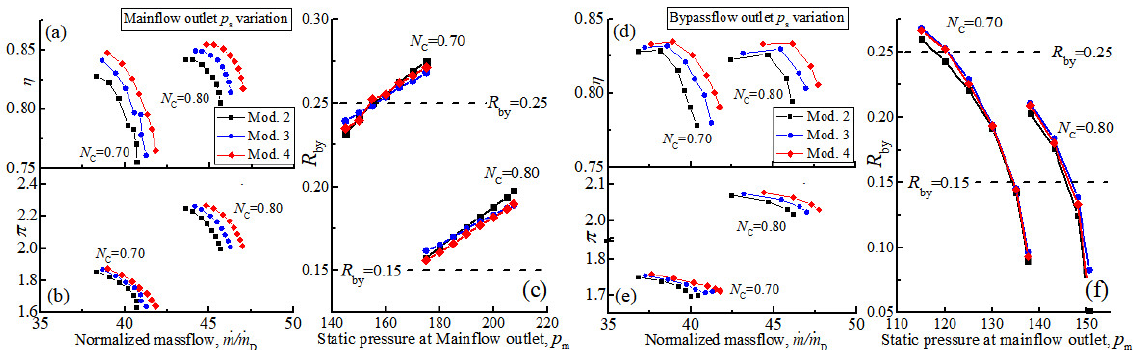
Figure 14. The aerodynamic characteristics of Mod.2, Mod.3 and Mod.4 at partial rotating speed (cid:1840) (cid:2887) = 0.8 and 0.7 ( a – c ) for main-flow characteristic and ( d – f ) for bypass-flow characteristic.